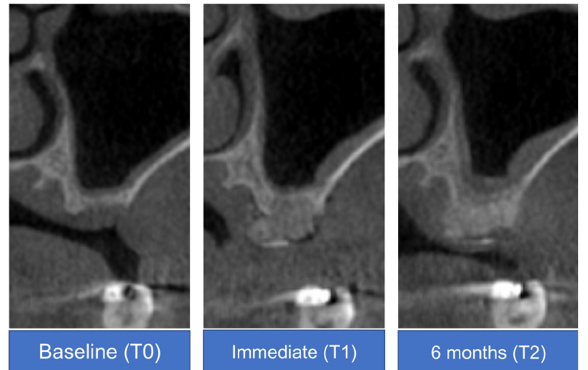
Figure 4. Cone-beam computed tomography analysis of a representative case at baseline (T0), immediately after surgery (T1), and at 6 months after surgery